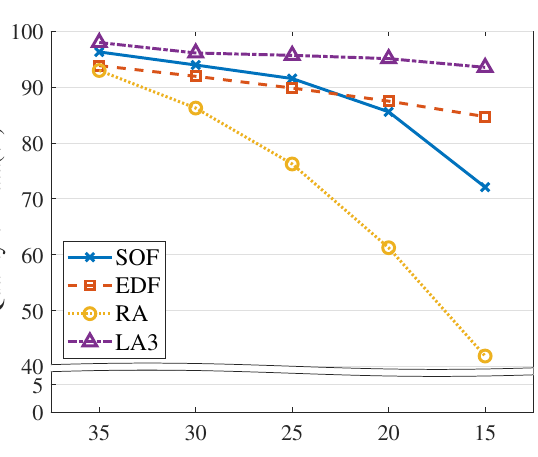
Figure 10. VOL scale.